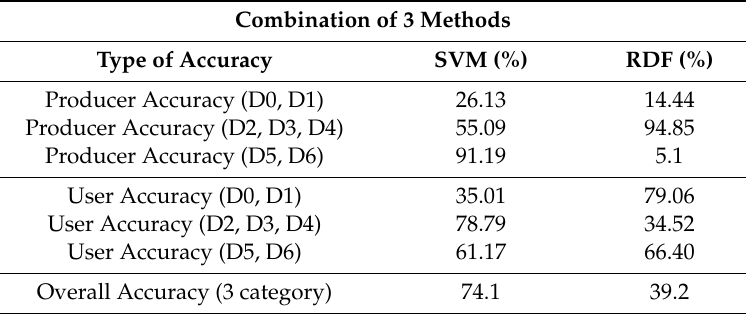
Table 3. Producer accuracy, user accuracy and overall accuracy [34] for RDF and SVM classifiers by considering the combination method